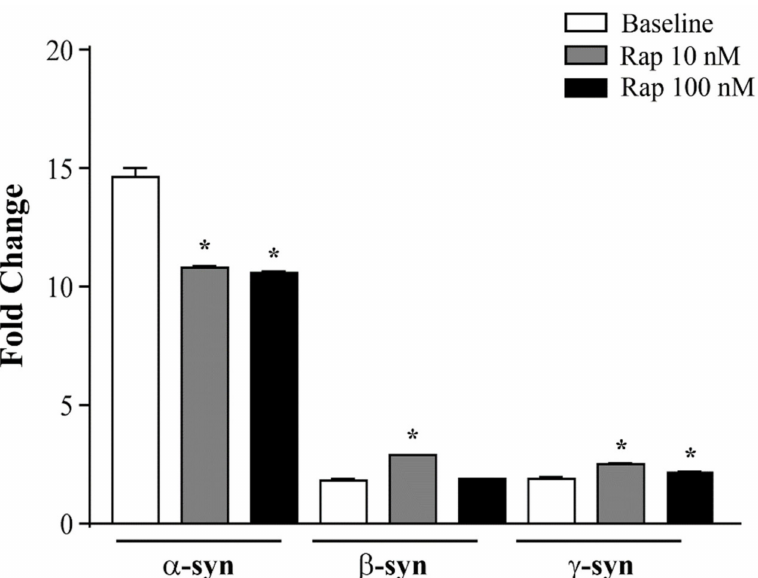
Figure 18. Effects of rapamycin on the mRNA levels of α -syn, β -syn, and γ -syn in U87MG cells. α -Syn, β -syn, and γ -syn gene transcripts were assessed by quantitative RT-PCR analysis in U87MG cells in baseline conditions (baseline), and following rapamycin exposure (Rap 10 nM and Rap 100 nM). Data are given as the mean ± SEM from n = 4 samples from N = 2 independent experiments, normalized with two different internal references, globin, and actin. * p < 0.05 compared with